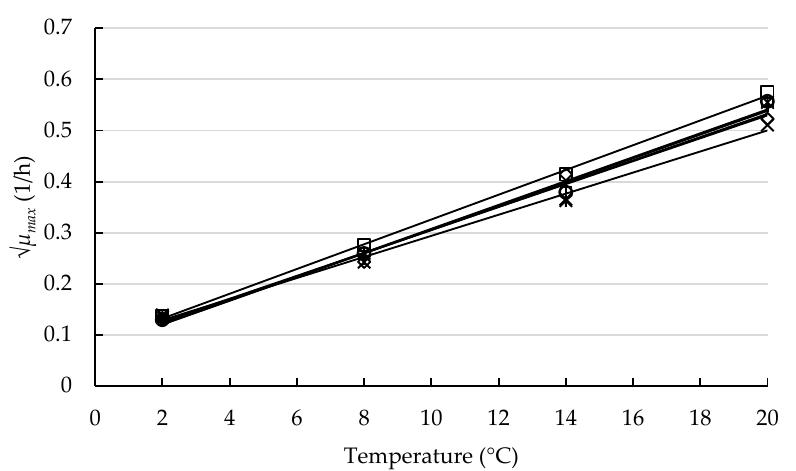
Figure 2. Graphical representation of the secondary models [26] developed for the six L. monocytogenes strains in smoked salmon pâté. The symbols (×, ○ , □, +, ◊, and ✳ for strains LMG 23773, LMG 23774, LMG 26484, 12MOB101LM, 12MOB102LM, and 12MOB107LM, respectively) represent the √ μ max values, and the lines correspond to the model fit.